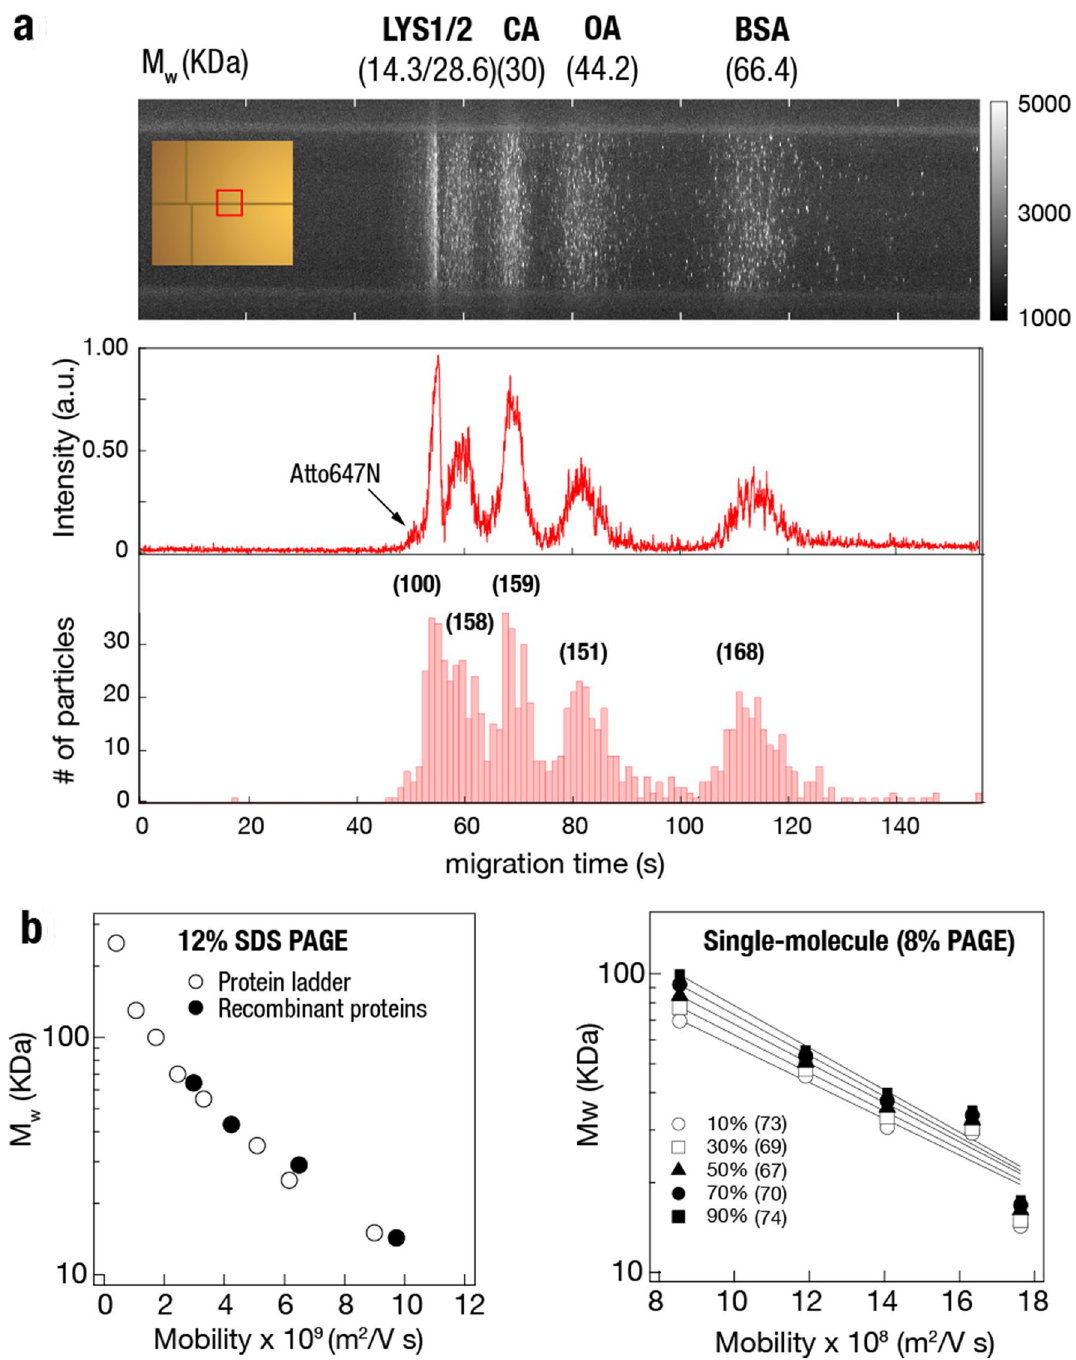
Figure 5. Comparison of protein migration times for differently sized purified proteins. ( a ) Top: Kymograph showing discrete protein bands for the monomers and dimers of LYS, followed by CA, OA, and BSA (see Methods for kymograph construction). The bare molecular weight plus fluorescent labeling weight (assuming 50% labeling efficiency) is given in brackets. Inlet shows the position on the chip. Bottom: Normalized fluorescent intensity measured as the fraction of pixels in a column above a certain threshold, versus protein migration time. Five peaks associated with the five protein populations are visible from the averaged intensity trace (middle panel), with an additional small peak representing the free fluorophores as indicated by the arrow. Lower panel displays a single particle analysis applied to the movie frames, allowing digital counting of number of proteins per peak. ( b ) Left panel: semi-log plot of the molecular weight of unlabeled proteins as a function of measured mobility analyzed in SDS-PAGE (Supplementary Fig. S2). Right panel: single-molecule migration analysis of Atto647N-labeled recombinant proteins shown in ( a ) assuming different levels of labeling efficiencies as indicated. Lines represent exponential fits to the data (fit χ 2 values shown in